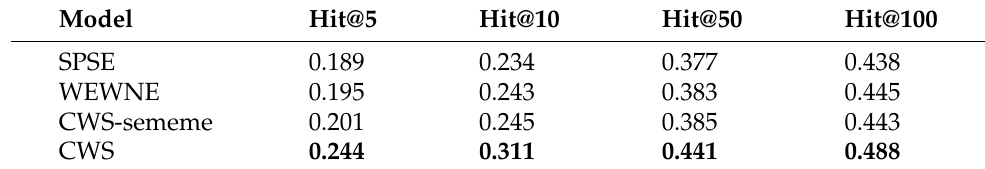
Table 4. Performance comparison of different models; the best results are shown in